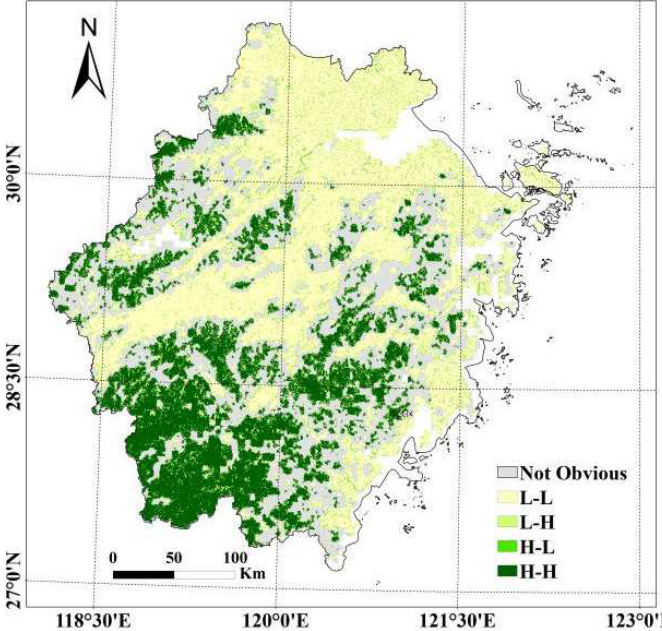
Figure 9. LISA aggregation map of NAI concentrations in Zhejiang in 2020.